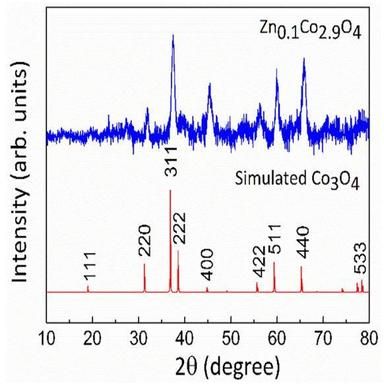
XRD pattern of synthesised Zn0.1Co2.9O4 sample compared with indexed simulated pattern of Co3O4.